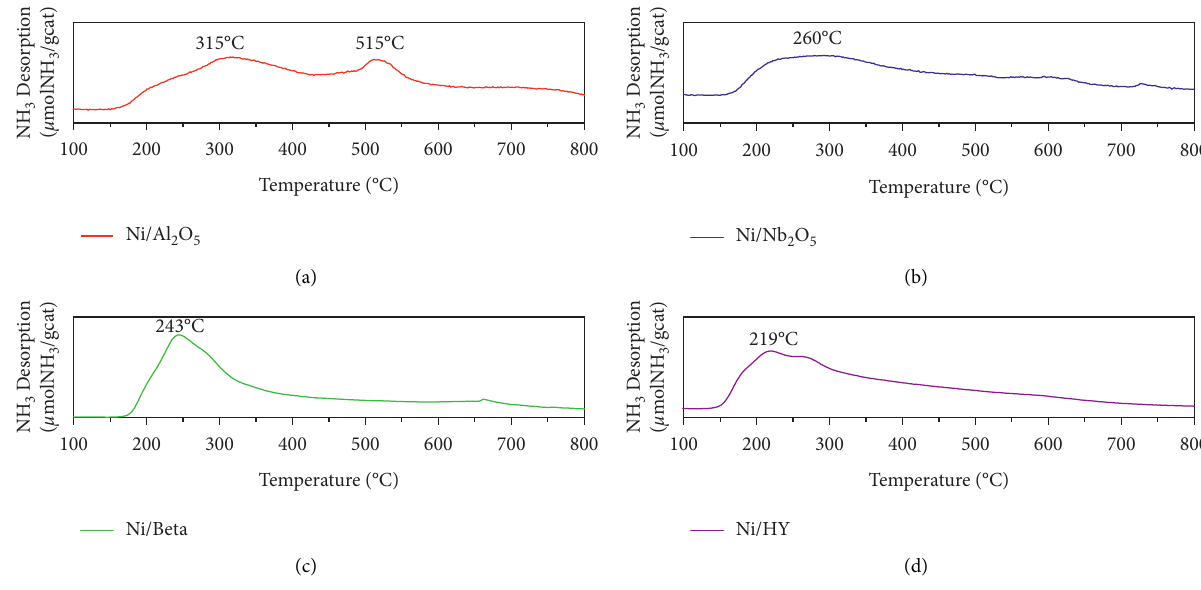
Figure 6: NH 3 -TPD profile of the Ni/Al 2 O 3 , Ni/Nb 2 O 5 , Ni/Beta, and Ni/HY